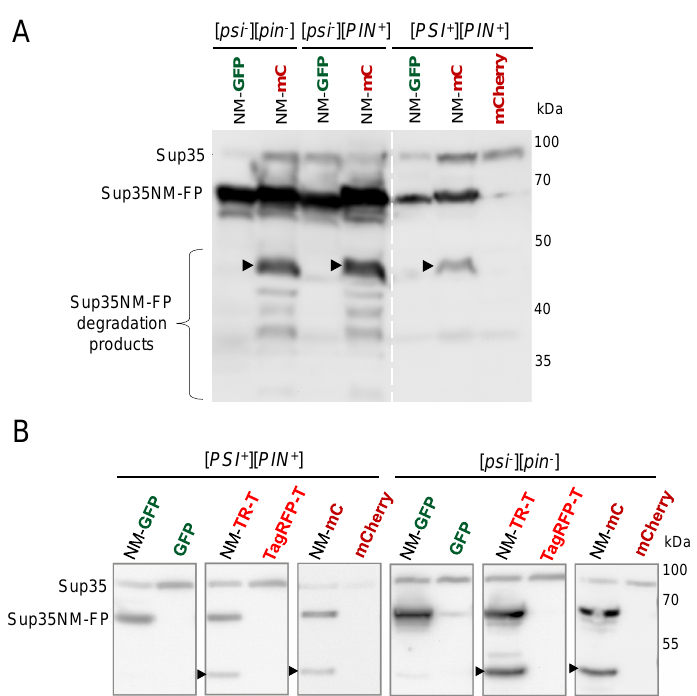
Figure 3. Both Sup35NM-TagRFP-T and Sup35NM-mCherry, but not Sup35NM-GFP, are subjected to proteolysis in yeast cells. ( A , B ) Western blot analysis of protein lysates from clones shown in Figure 2A and Figure 1A, respectively. Arrowheads indicate major additional product detected by anti-Sup35NM antibodies, which is similar in weight to the untagged Sup35NM. FP—fluorescent protein (GFP, or mCherry, or TagRFP-T).